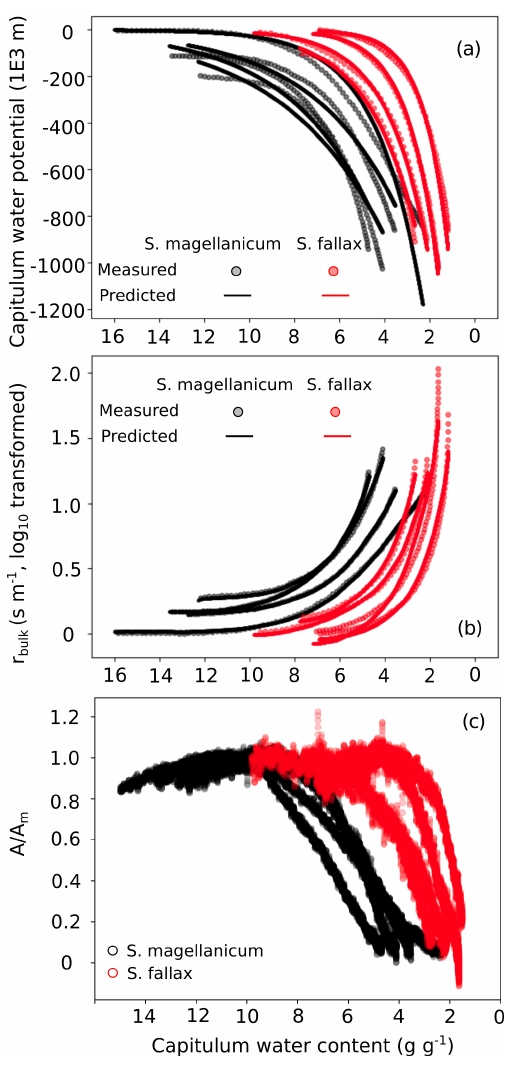
Figure B3. Responses of (a) the capitulum water potential, (b) the bulk resistance of evaporation, and (c) the net photosynthesis to changes in the capitulum water content ( W cap ) of two Sphagnum species typical to hummocks ( S. magellanicum , black) and lawns ( S. fallax , red). As the measured results are based on the drying ex- periment starting with fully wetted capitula characteristic for both species, the x axis is shown from high to low W cap . The values predicted in panels (b) and (c) are based on linear models with the parameter values listed in Tables B2 and B3 and predictor values from the drying